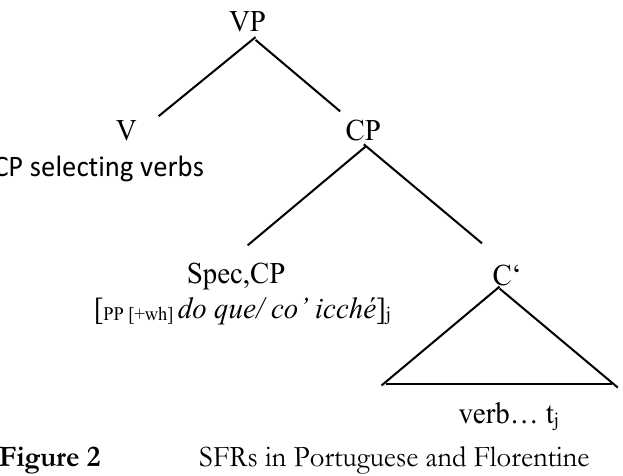
SFRs in Portuguese and